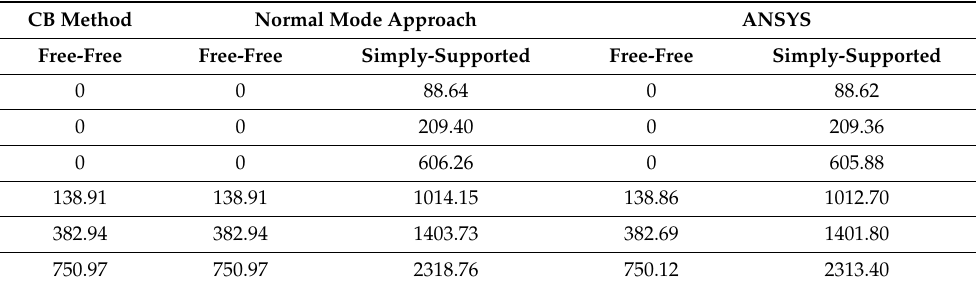
Table 3. Comparative analysis of the frequencies from different methods